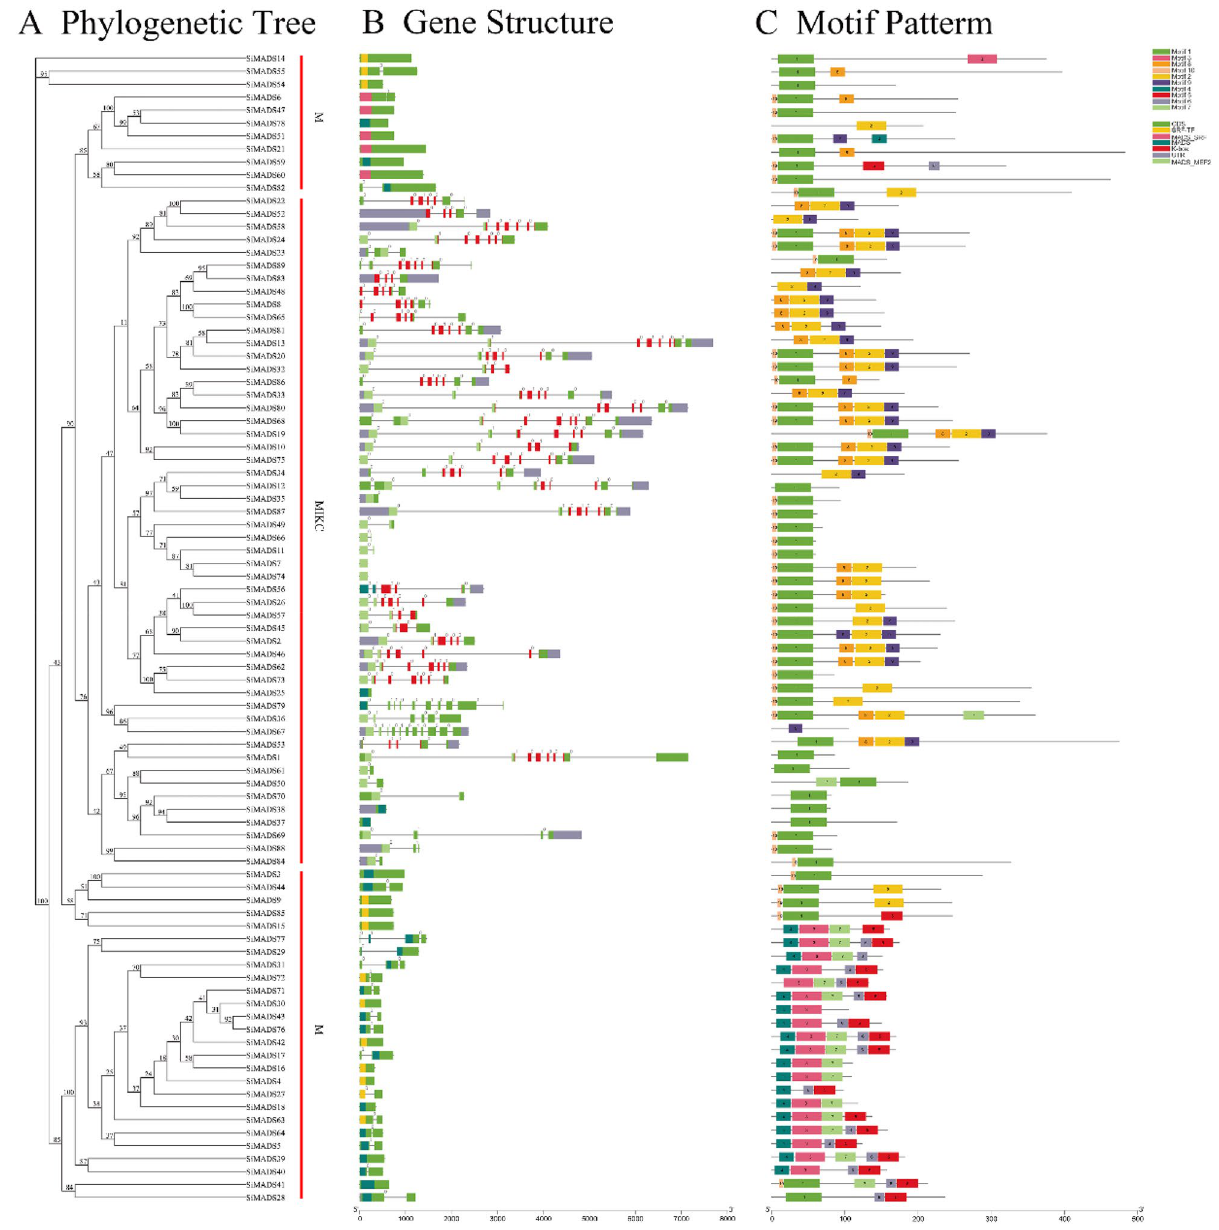
Figure 2. Phylogenetic relationships, gene structure and architecture of the conserved protein motifs in 89 genes from S. italica . ( A ) The phylogenetic tree was constructed based on the full-length sequences of S. italica MADS-box proteins. ( B ) Exon–intron structure of S. italica MADS-box genes. Lines represent introns, boxes represent exons, and domains are color-coded. Number indicates the phase of the corresponding intron. ( C ) Amino acid motifs in the Si MADS-box proteins (1–10) are represented by colored boxes. Black lines indicate relative protein lengths. Sequence information for each motif is provided in Table